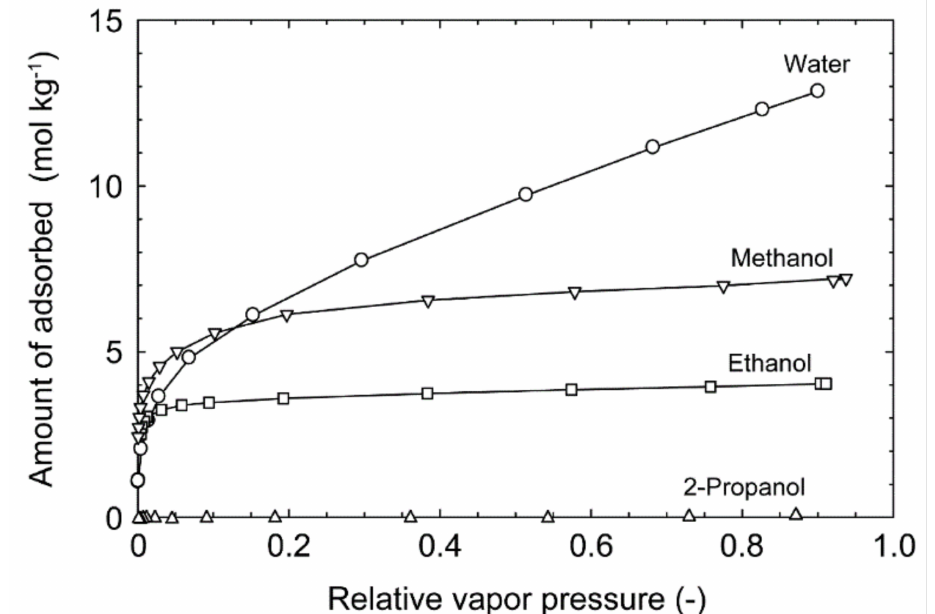
Figure 4. Adsorption isotherms of water, methanol, ethanol, and 2-propanol at 303